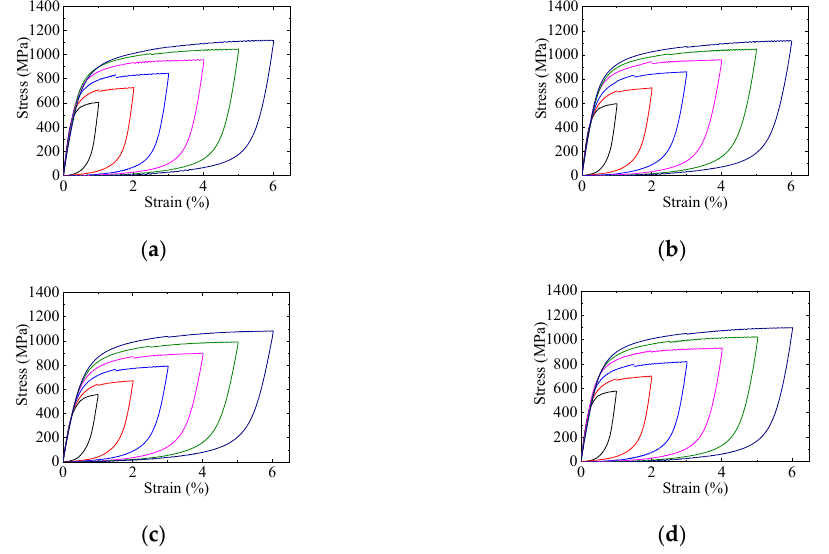
Figure 18. Relative hysteretic curves of S316. ( a ) S ‐ NT; ( b ) S ‐ 900 ‐ 1; ( c ) S ‐ 900 ‐ 2; ( d ) S ‐ 900 ‐ 3.